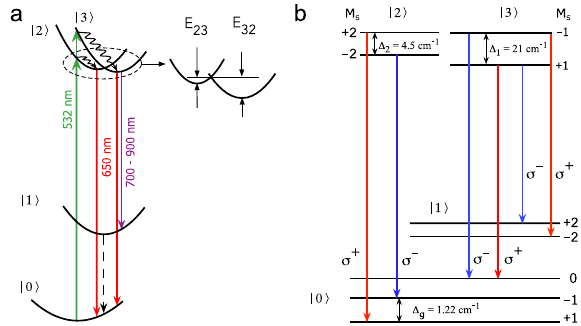
Figure 5. Energy levels diagram of the ORPL centre in SiO 2 :Bi. ( a ) General layout. Wavy arrows correspond to fast non-radiative relaxation. Dashed arrow: possible, but unobserved yet transition. ( b ) Magnetic sublevel structure. All sublevels are labelled by the quantum numbers M S corresponding to the quantized projections of the spin S .